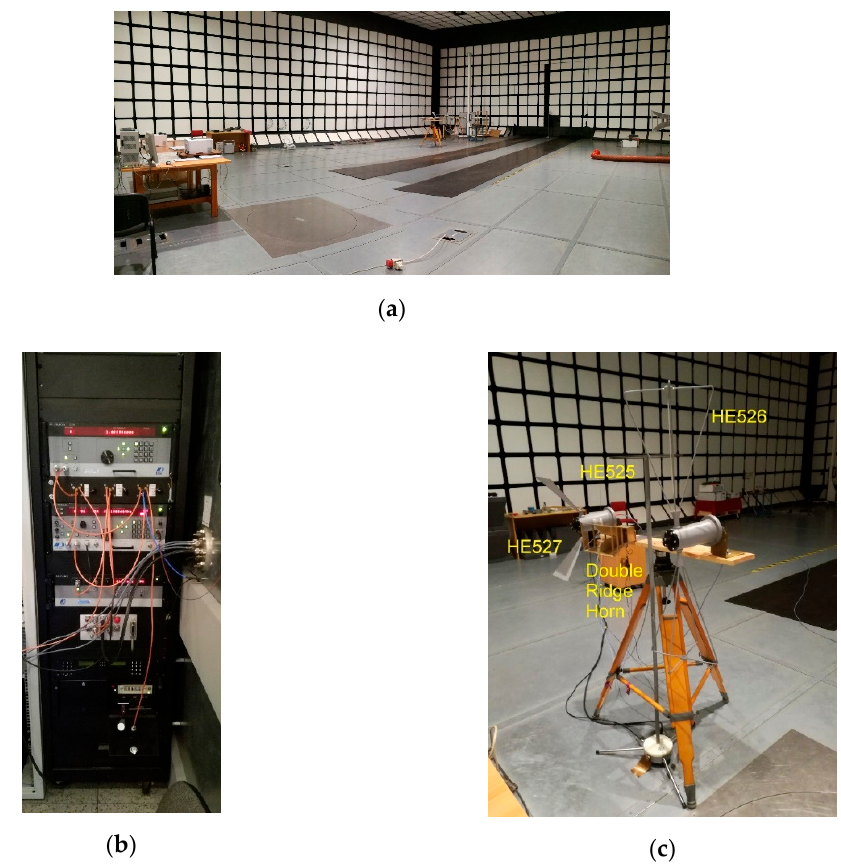
Figure 8. An anechoic chamber ( a ), a DSI-1550-A measurement system ( b ), and an antenna system ( c ).